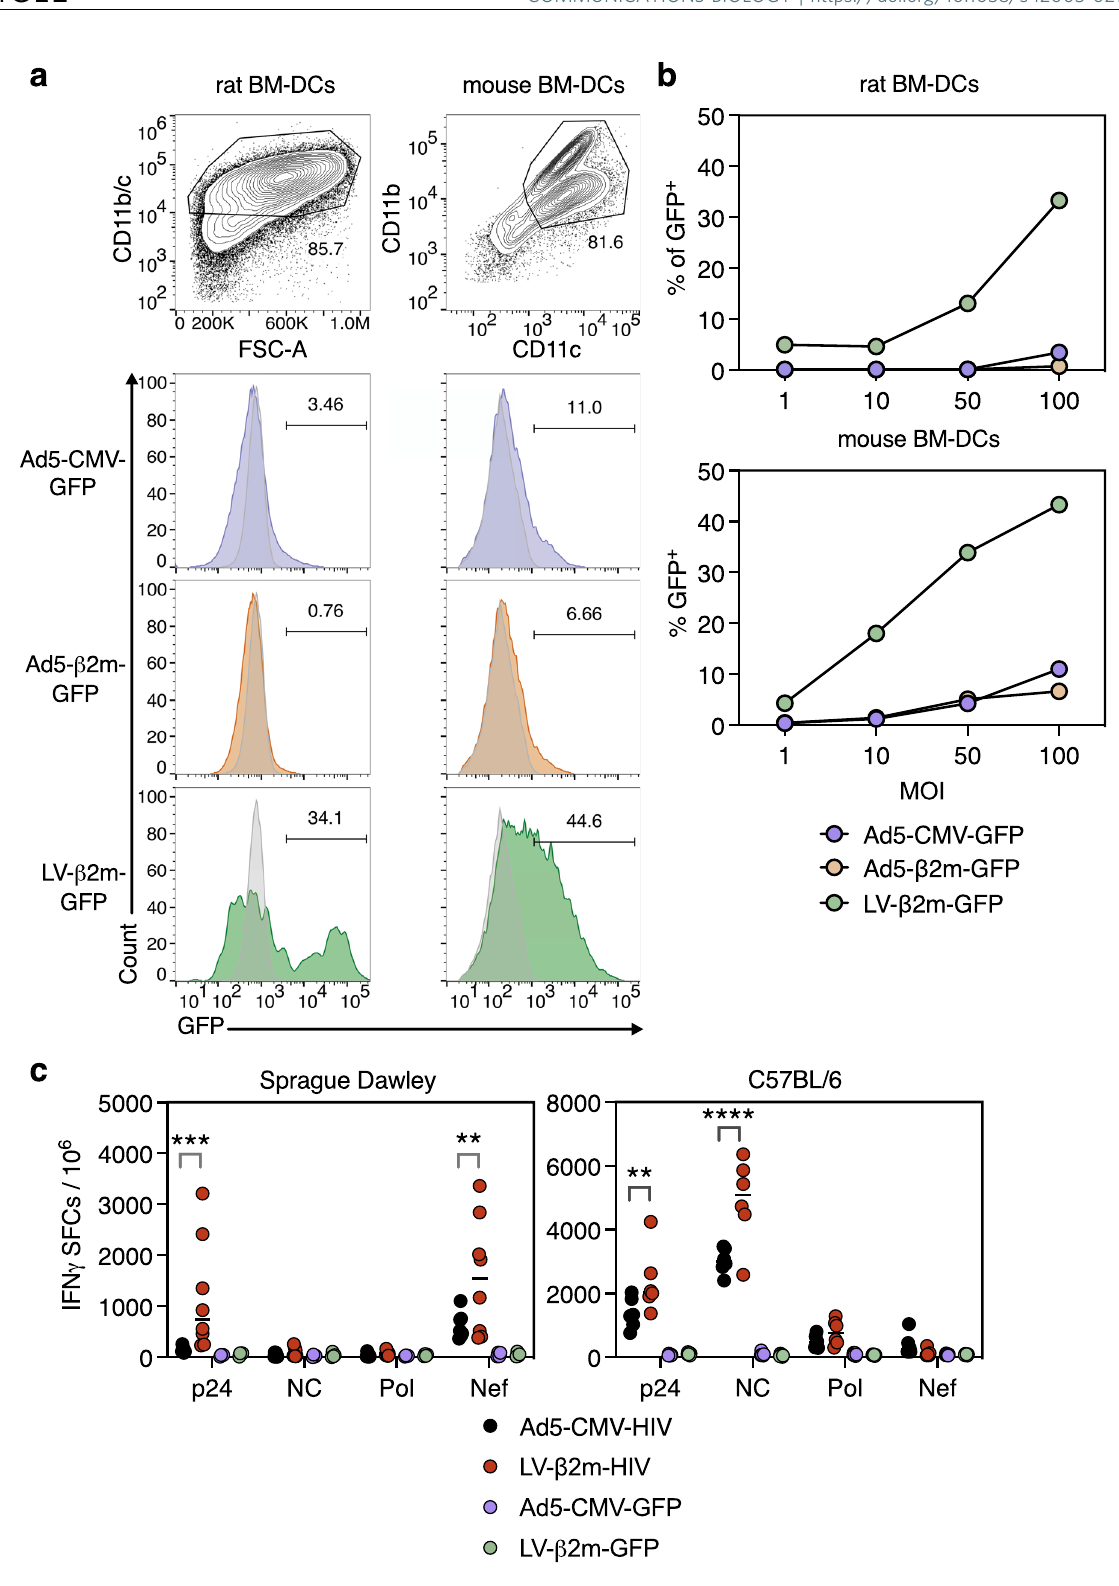
Adenoviral vector construction, production, and titration . Ad5 was produced using the ViraPower Adenoviral Promoterless Gateway Expression Kit (Thermo Fisher Scienti fi c, France). The CMV-BamH1-Xho1-WPRE or β 2m-BamH1-Xho1- WPRE sequence was ampli fi ed from the pFLAP Δ U3- β 2m-WPRE or pFLAP Δ U3- CMV-WPRE by PCR, using the forward primer encoding the attB1 in the 5 ′ end and reverse primer encoding both the attB2 and SV40 polyA signal sequence in the 5 ′ end. The attb-PCR product was fi rst cloned into the gateway donor vector pDORN207, via BP Clonase reaction, to form the pDORN207 CMV-BamH1-